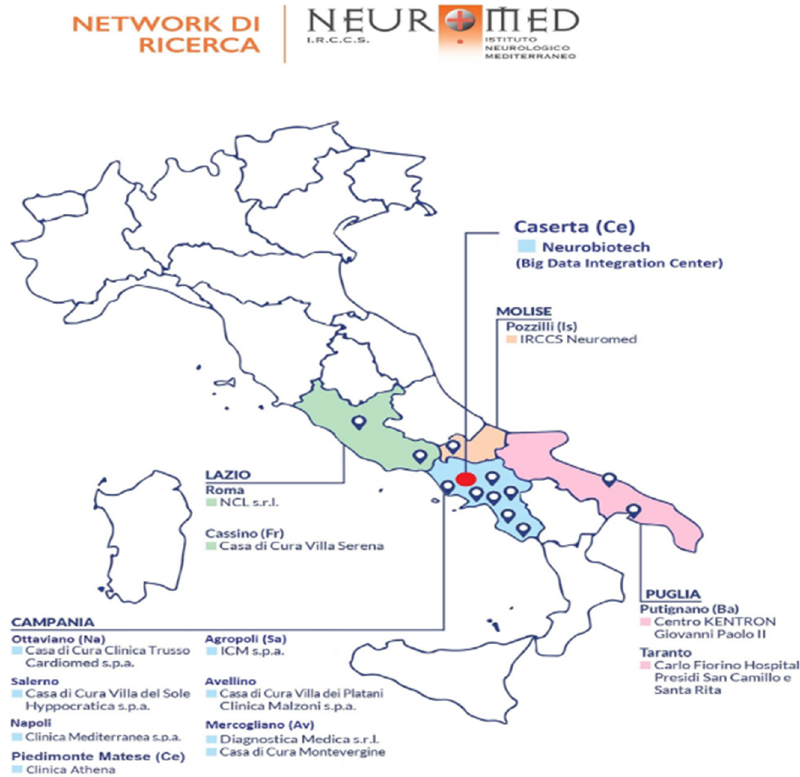
Figure 1. Geographical location of the hospitals/clinics involved in the